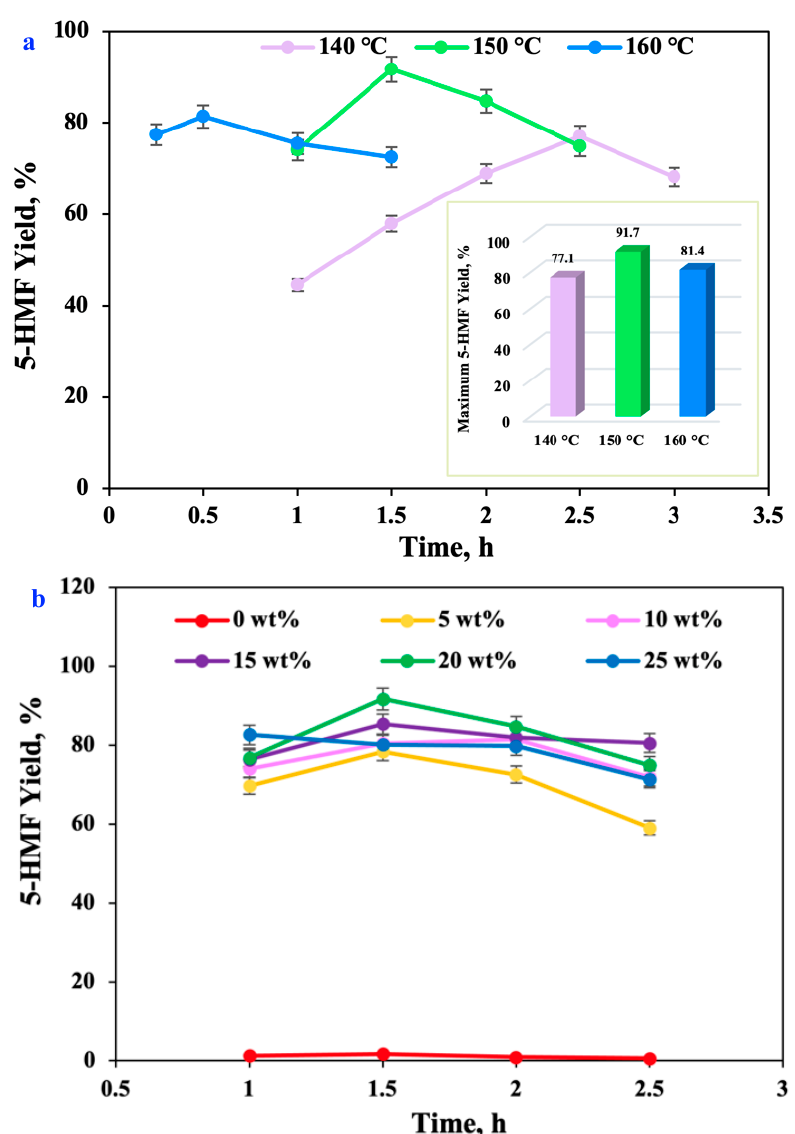
Figure 2. Effect of solvent B:Gly composition (0–25 wt%) on the 5-HMF formation [SG(SiO 2 ) 3 wt%, 150 °C, 1–2.5 h] ( a ); Effect of reaction duration (0.25–3 h) and reaction temperature (140–160 °C) on the 5-HMF formation [B:Gly 20 wt%, SG(SiO 2 ) 3 wt%] ( b ).